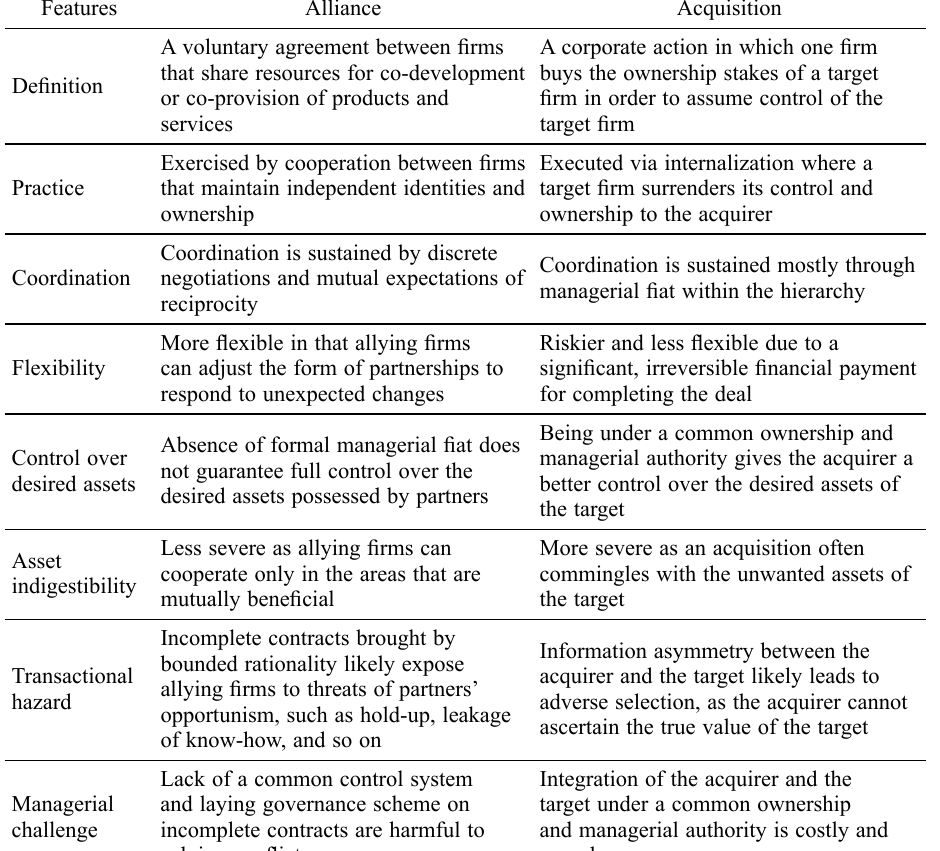
Table 1. Comparison of key characteristics between alliances and acquisitions